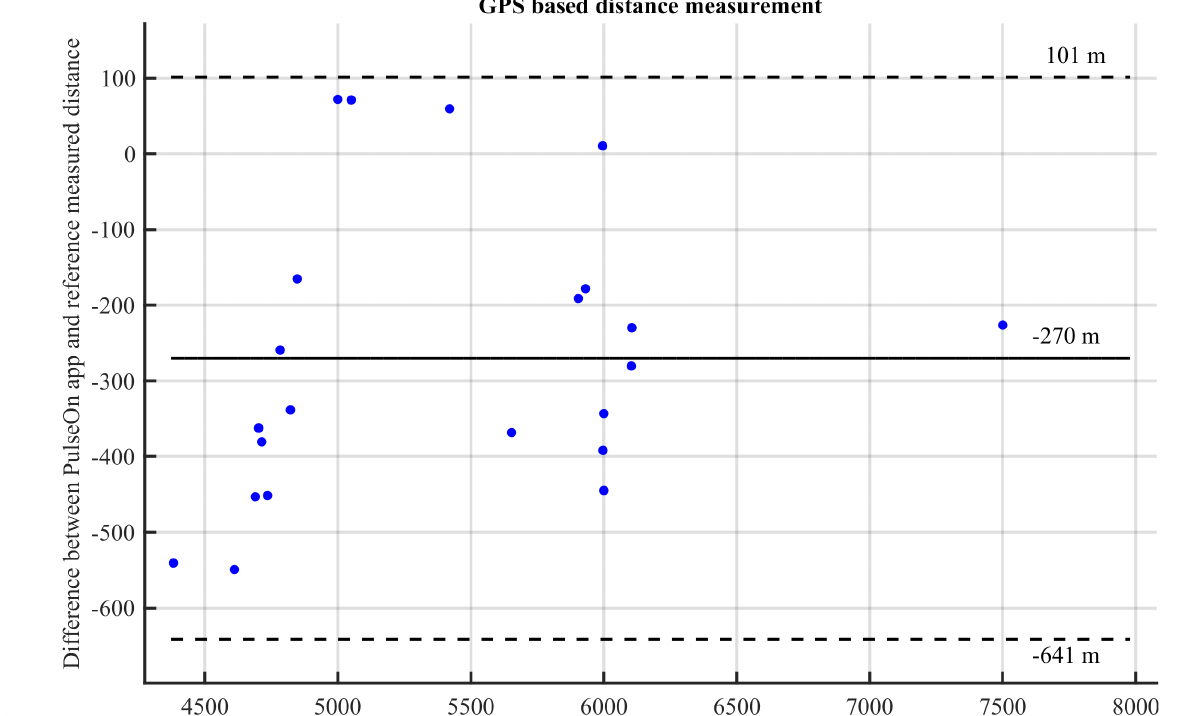
Figure 3. Bland−Altman plot comparing the phone GPS distance measured by the PulseOn app and a reference tracker distance estimation during outdoor running protocol (solid horizontal line: bias, dashed lines: 95% confidence limits of